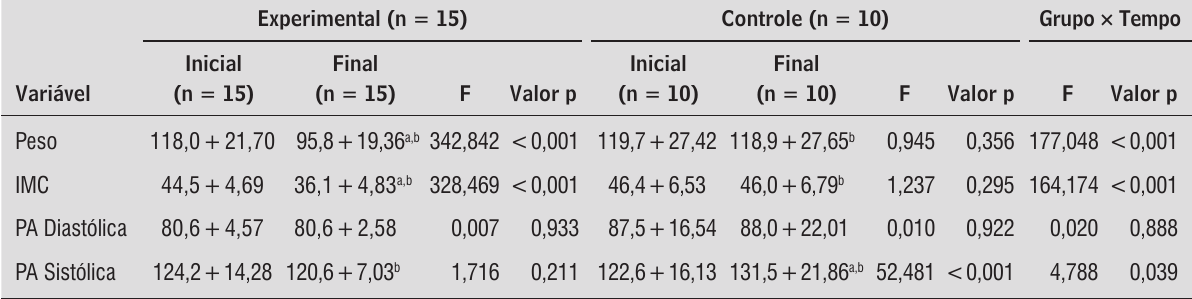
Tabela 1 - Médias e desvios-padrões das variáveis antropométricas e pressóricas iniciais e finais dos